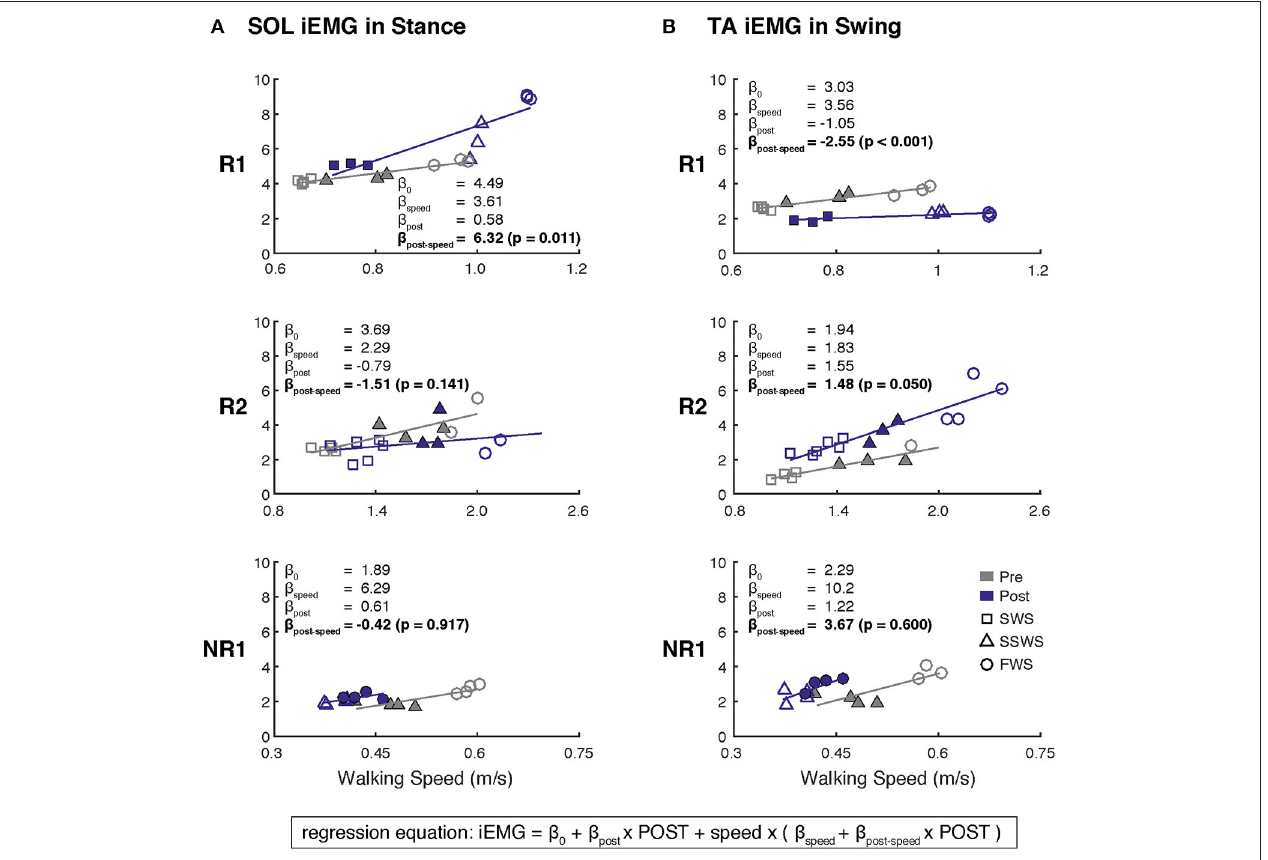
FIGURE 3 | Changes in muscle activity modulation across walking speeds after FastFES for (A) Soleus (SOL) during stance and (B) Tibialis Anterier (TA) during swing. Linear regressions between iEMG and walking speed were generated before and after FastFES to examine the degree to which muscle activity was modulated with walking speed. A single regression equation was identified for each muscle in each participant, where the variable speed is walking speed minus the average self-selected walking speed at pre-training (light-colored triangles). Analysis was focused on whether the slopes of the regression for pre-training and post-training were significantly different (H 0 : β post − speed = 0). Note that filled markers denote those trials with similar speeds pre- and post-training that were used in Figure 2 . Participant R1 increased and decreased modulation of SOL and TA across walking, respectively. Participant R2 increased modulation of TA across walking speeds. Participant NR1 showed no changes in muscle activity modulation after FastFES (SWS, slow walking speed; SSWS, self-selected walking speed; FWS, fast walking